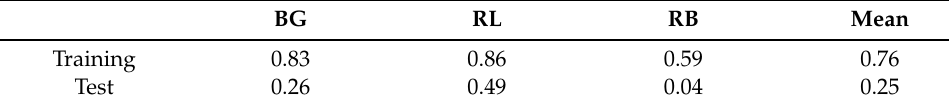
Table 10. IoU scores for Rice blast in Experiment A.